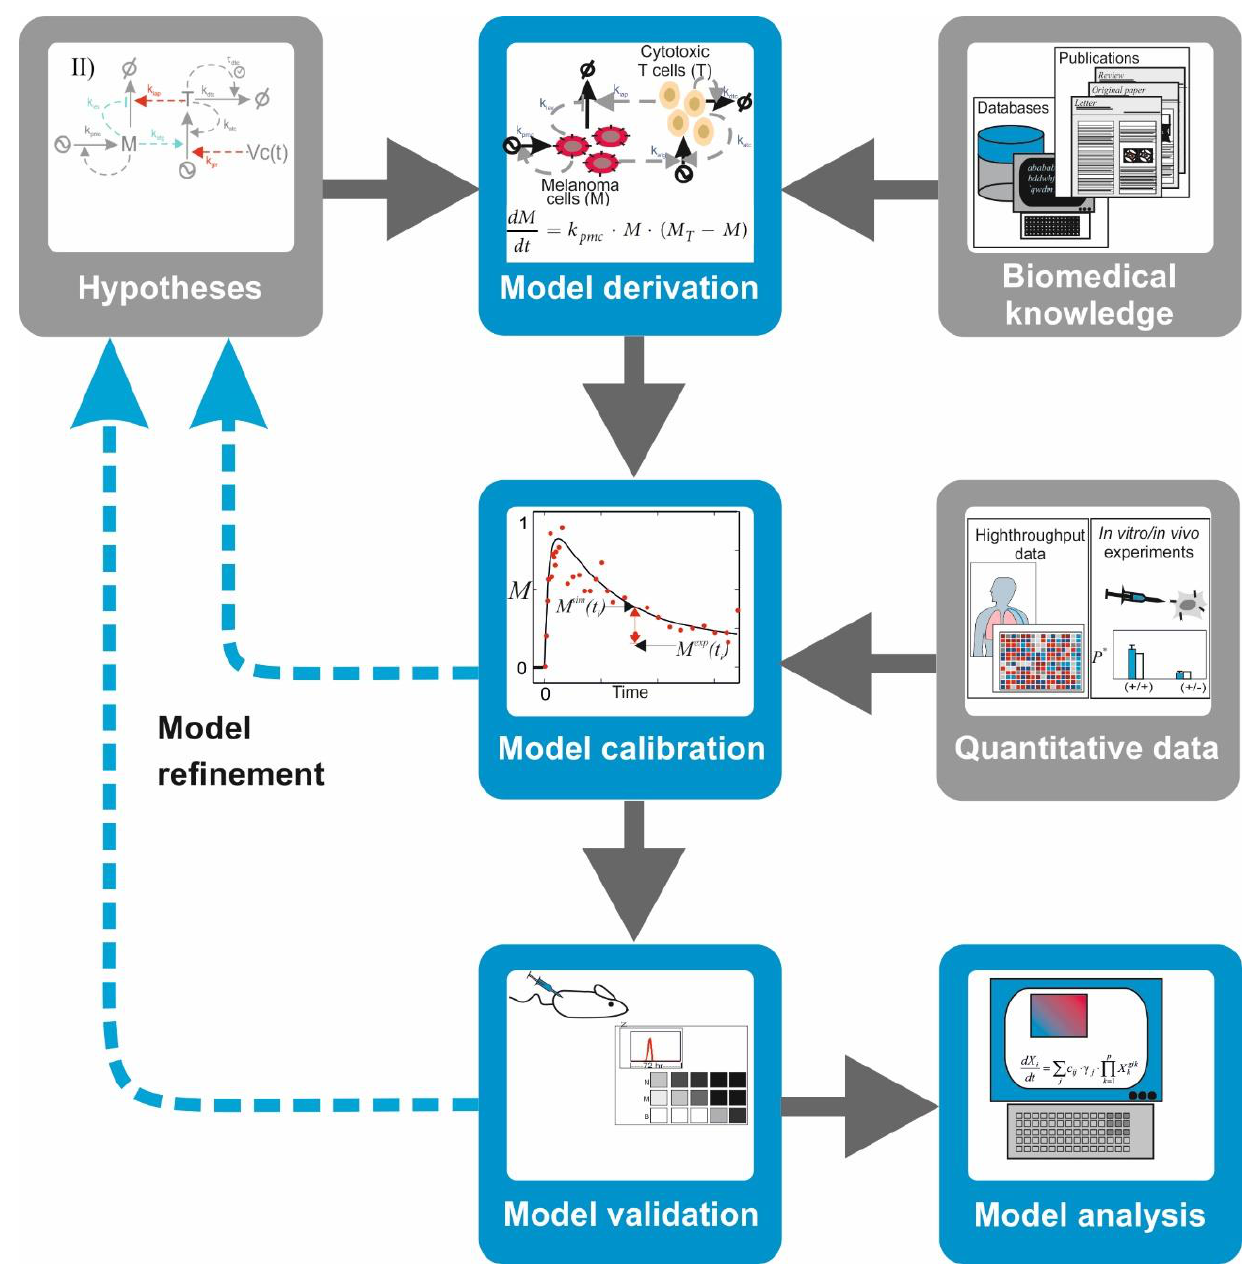
Figure 3. The modelling workflow in biomedicine: during model derivation, the biological knowledge and hypotheses about the studied system are encoded in a mathematical model. In model calibration, quantitative experimental data are added to characterize the mathematical model and to give values to the model parameters. In model validation, the ability of the model to make predictions is assessed by judging the agreement between new quantitative data and equivalent simulations of the calibrated model. In model analysis, a validated model is used to investigate the system using computer simulations or other tools like stability analysis.